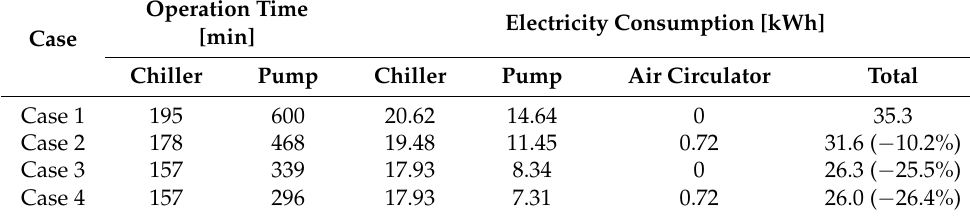
Table 5. System operation time and electricity